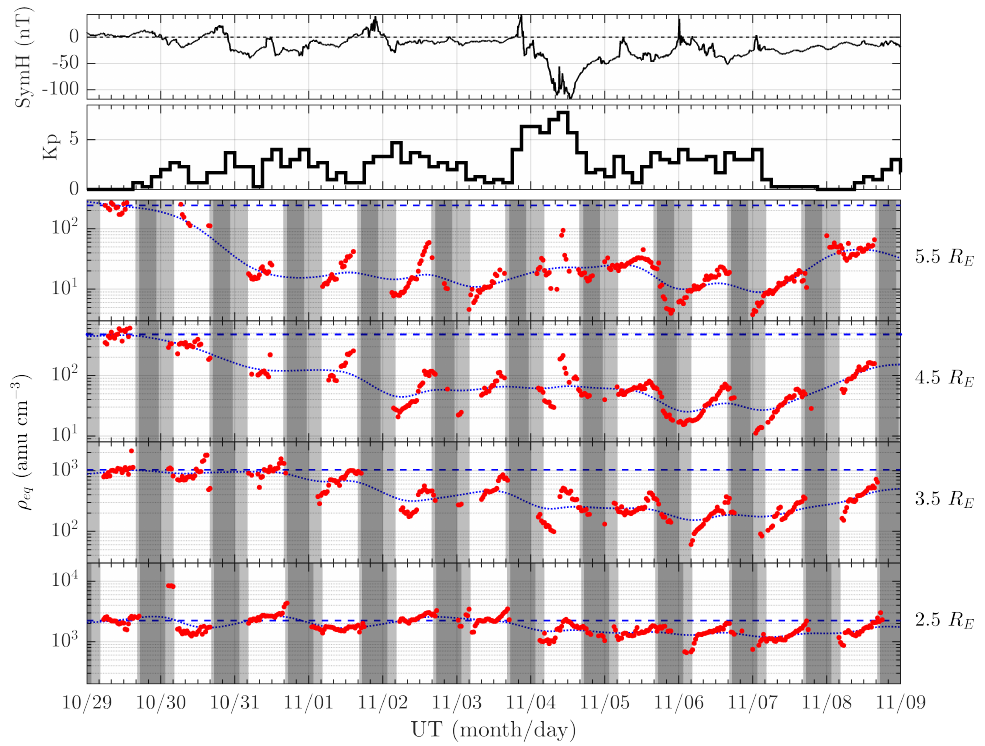
Figure 3. From the top: the SymH index, the Kp index, and the equatorial plasma mass density inferred at 5.5, 4.5, 3.5, and 2.5 R E , respectively. Red dots are the observation points, while the blue dotted curves are smoothing splines highlighting the long-term variations. Blue dashed lines are the average plasma mass density values observed on the quiet day 29 October, and used as a reference for saturated conditions. Shadowed areas indicate times in which one (light-gray) or both (dark-gray) footprints of the field line passing to the observation point are not lighted by the